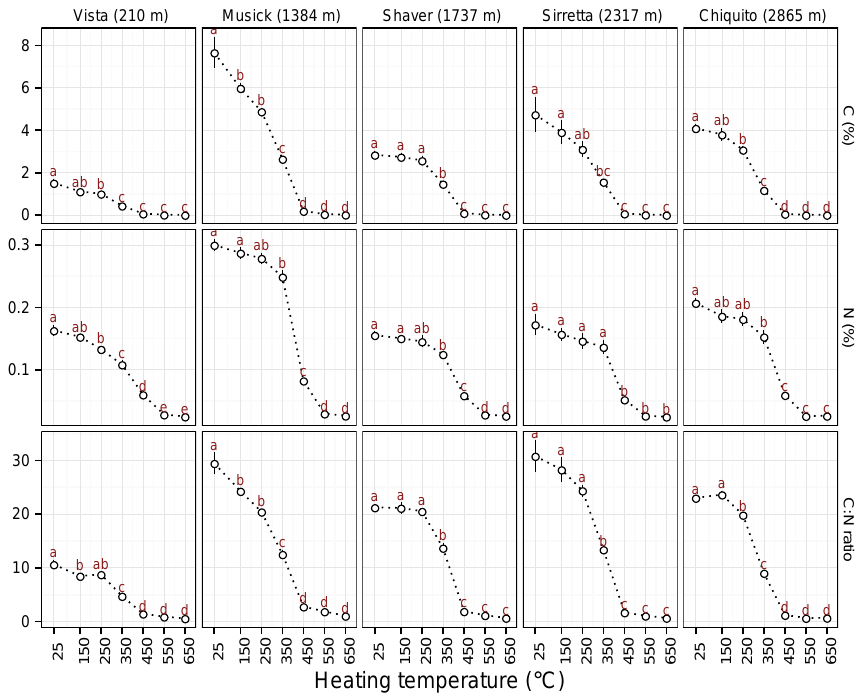
Figure 9. Carbon concentration, Nitrogen concentration and C:N atomic ratio changes with increase in heating temperature. Error bars represent standard error where n = 3. Different letters represent significantly different means ( p < 0.05) at each temperature after Tukey’s HSD